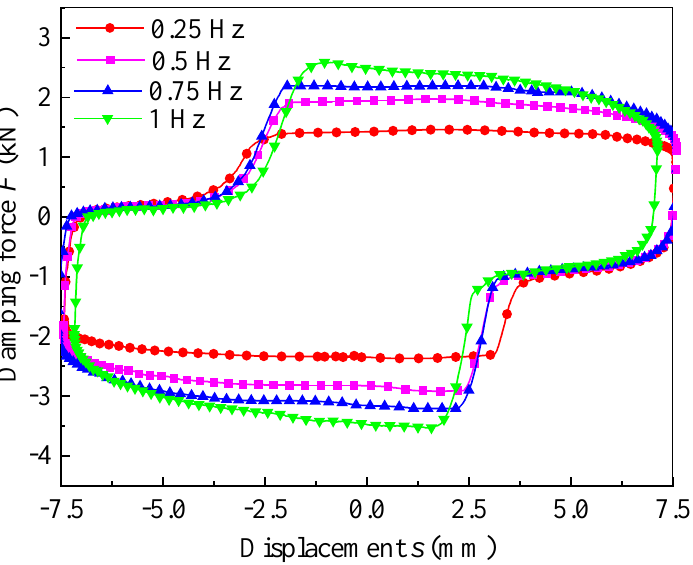
Figure 31. Variation of damping force relative to displacement under different frequencies.